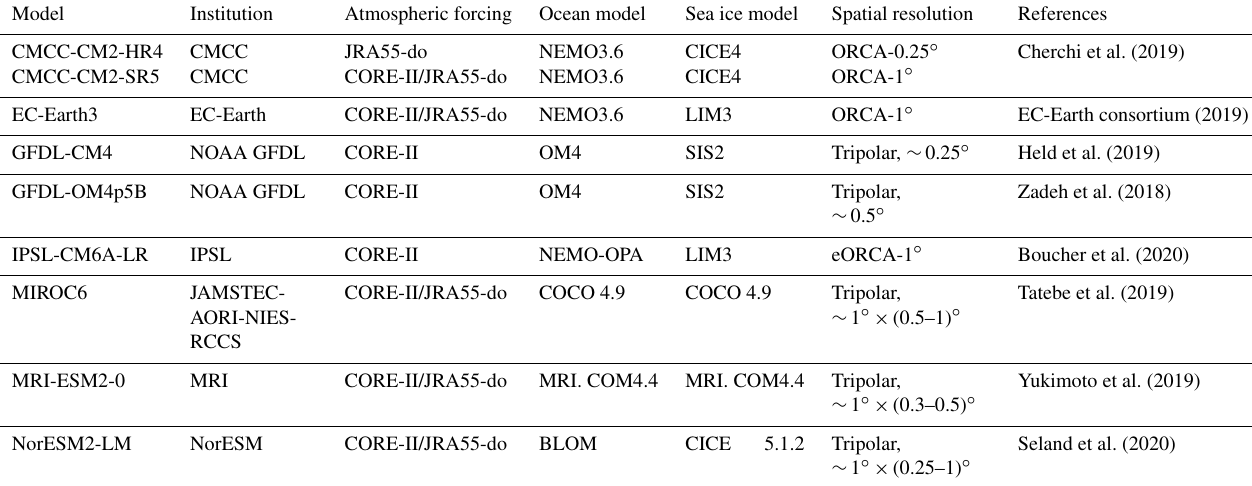
Table 2. The details of nine CMIP6-OMIP models evaluated in the study. Model